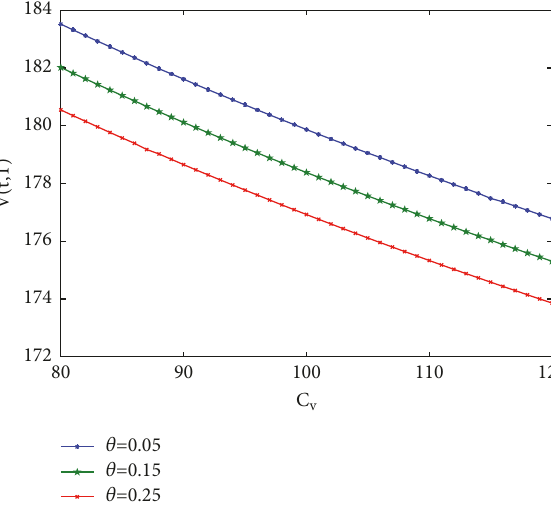
Figure 3: The warrant bond price with different 𝛾 .